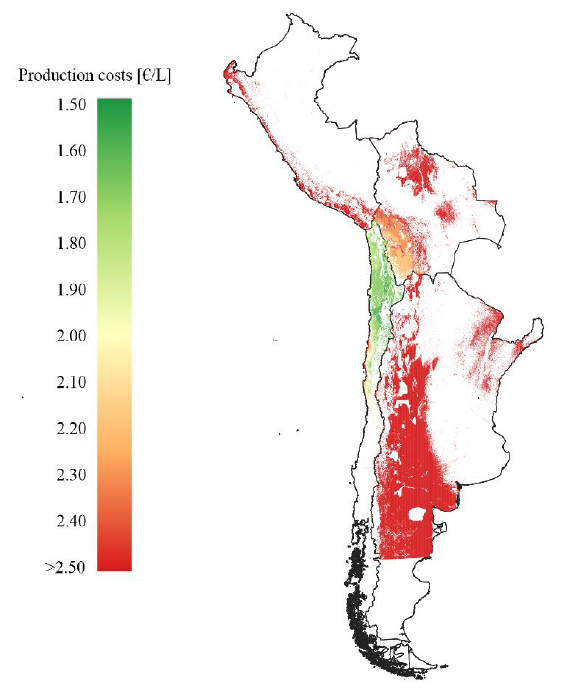
Figure A9. Production costs of solar thermochemical jet fuel in South America.